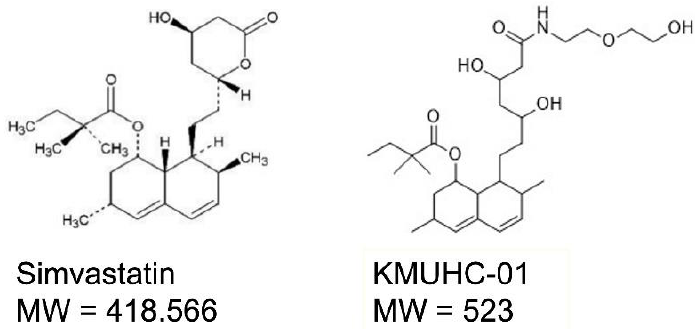
Figure 1. Structural formula and molecular weight (MW) of KMUHC-01 and simvastatin.